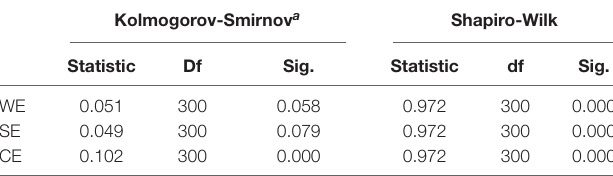
TABLE 3 | Test of normality for WE, SE, and